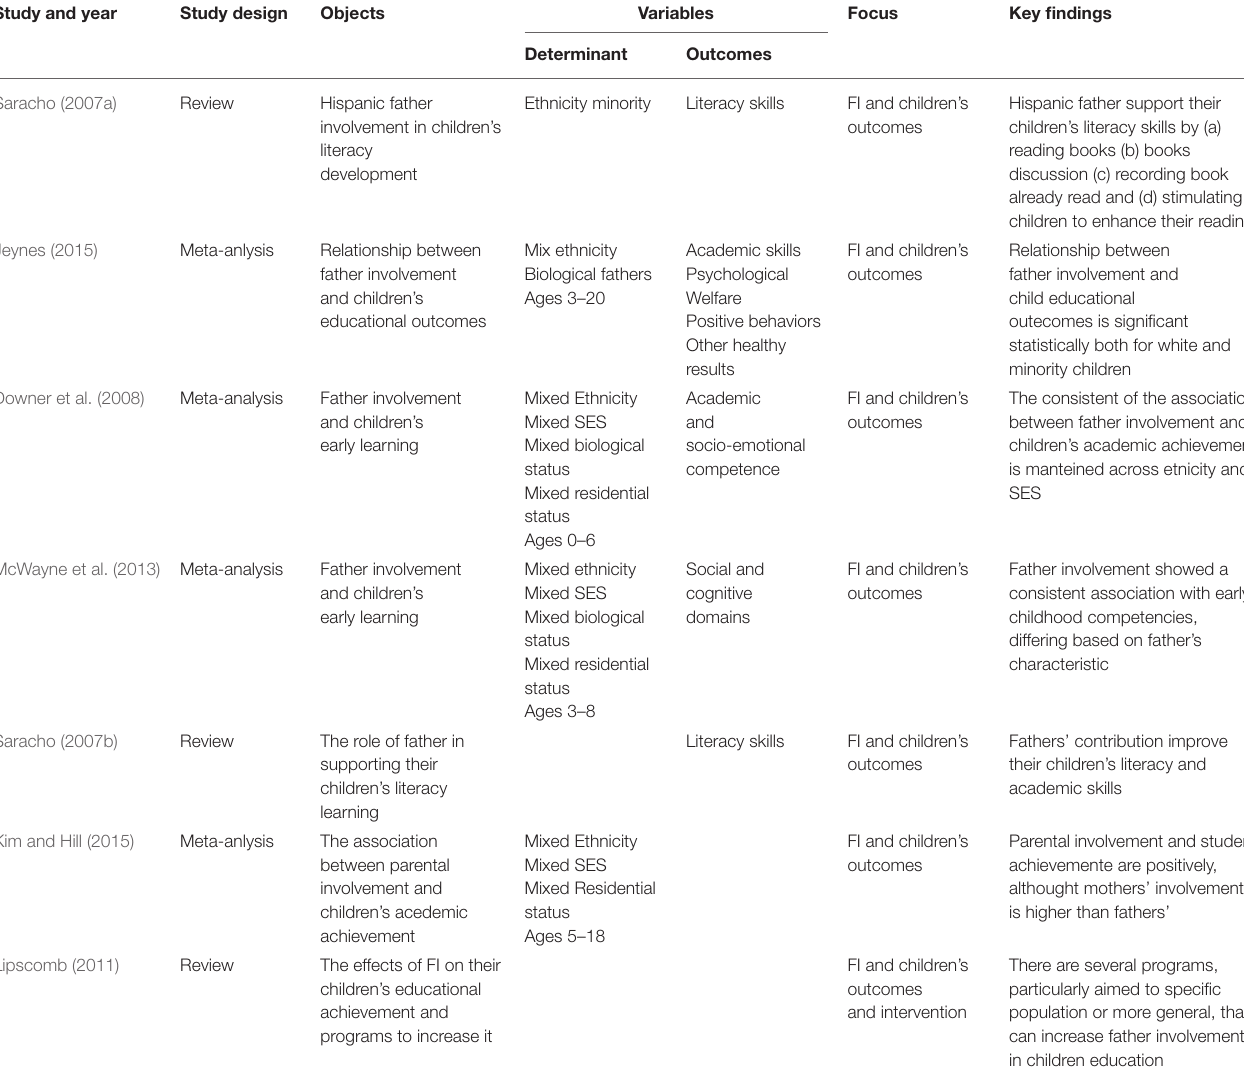
TABLE 2 | Reviewes and meta-analysies included in the